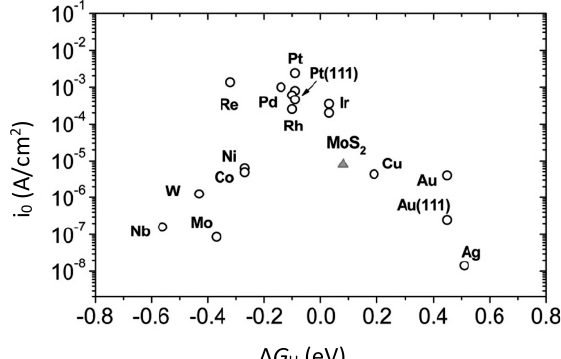
Figure 14. Volcano plot of the exchange current density as a function of the DFT ‐ calculated Gibbs free energy of adsorbed atomic hydrogen for nanoparticulate MoS 2 and the pure metals. Reprinted with permission from [42]. Copyright 2007 Science.